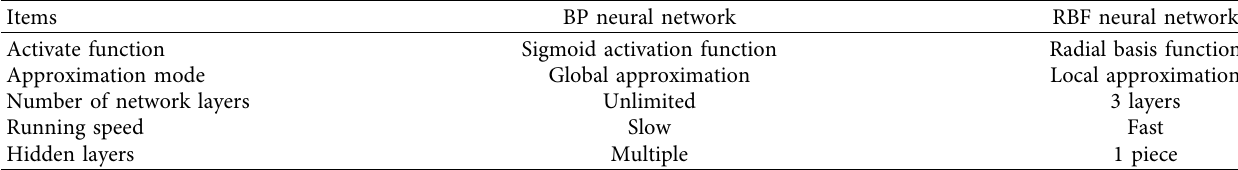
Table 2: Differences between RBF and BP neural